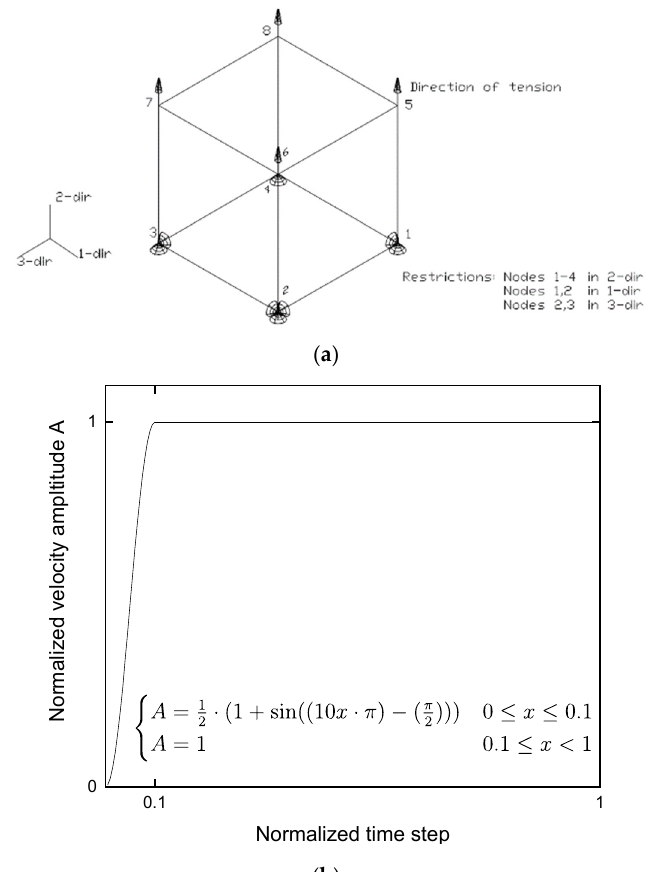
Figure 13. ( a ) Singular element’s boundary conditions used in FE simulation; ( b ) smooth piecewise application of velocity